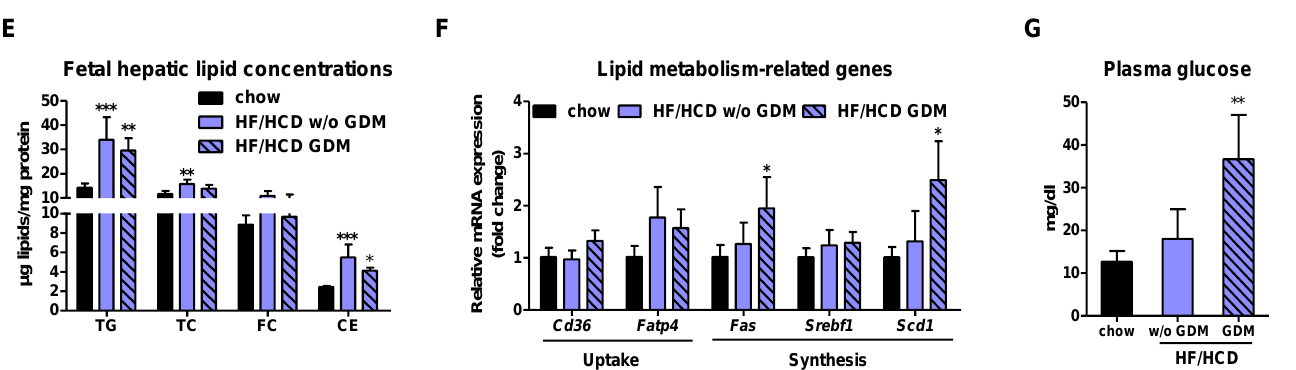
Figure 4. Elevated plasma and hepatic lipid concentrations in offspring of HF/HCD-fed dams without and with GDM. ( A ) Fetal brain weight, ( B ) liver weight, and ( C ) brain-to-liver ratio. Fetal ( D ) pooled plasma lipid concentrations ( n = 3 chow, 6 HF/HCD w/o GDM, 3 HF/HCD GDM), ( E ) hepatic lipid content ( n = 5), and ( F ) hepatic gene expression of lipid metabolism-related genes ( n = 4). ( G ) Plasma glucose concentrations in pooled fetal plasma samples ( n = 3 chow, 6 HF/HCD w/o GDM, 3 HF/HCD GDM). Data represent mean + SD and were analyzed with 1-way ANOVA followed by Bonferroni post hoc test. * p < 0.05, ** p ≤ 0.01, *** p ≤ 0.001 indicates the comparison to the chow condition.